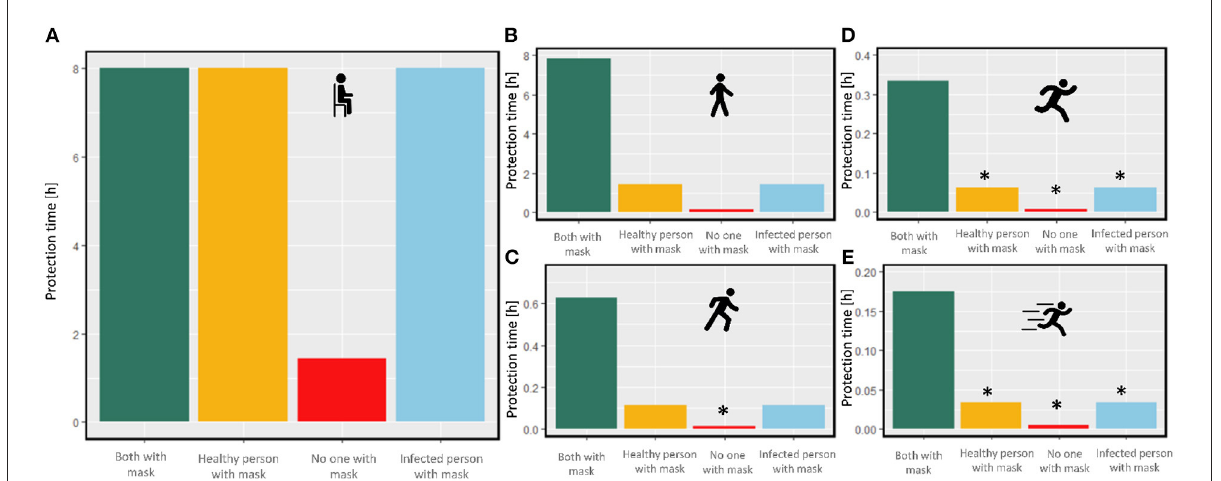
FIGURE7 Protection time for a healthy person in an office room during different activity levels. (A) level 1 (e.g., sitting), (B) level 2 (e.g., walking), (C) level 3 (e.g., climbing), (D) level 4 (e.g., running), (E) level 5 (e.g., sprinting), with different conditions with and without the mask. The star represents the too low protection time which is not compatible with the well-mixed assumption (the icons are from https://www.flaticon.com/).